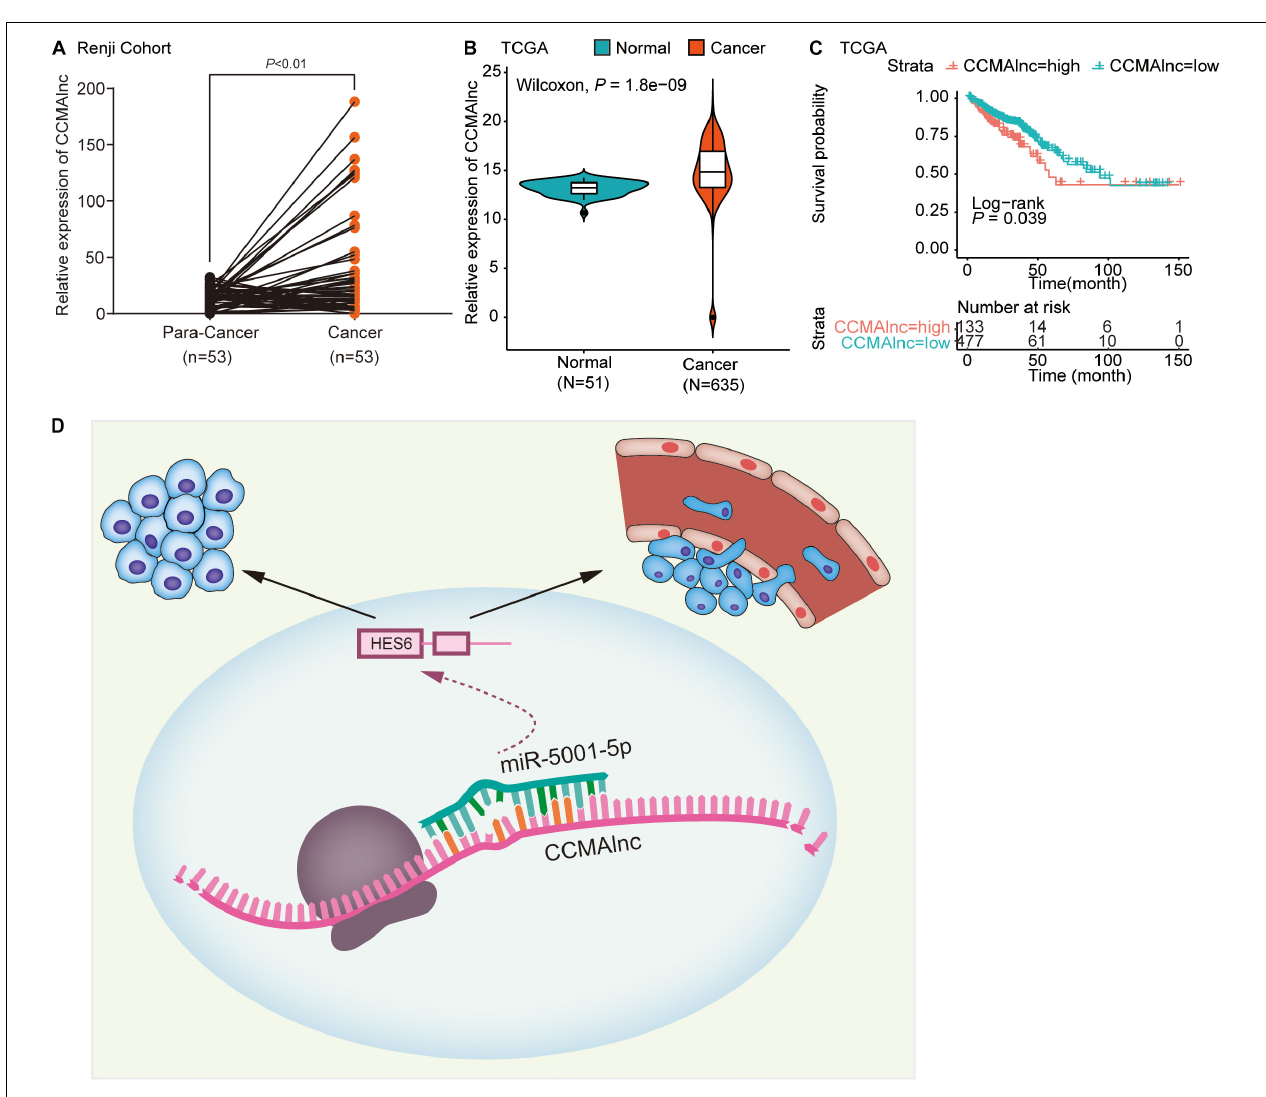
FIGURE 6 | CCMAlnc is upregulated in CRC and associated with poor prognosis. (A) Statistical analysis of CCMAlnc expression in CRC and the paired adjacent normal tissues of the Renji cohort ( n = 53). (B) The expression of CCMAlnc in CRC and normal tissues in the TCGA database. (C) Survival was analyzed and compared between patients with high and low CCMAlnc expression in the TCGA database. (D) Schematic representation of the mechanism of the CCMAlnc/ miR-5001-5p axis as a switch that regulates human CRC progression by stabilizing the expression of HES6.